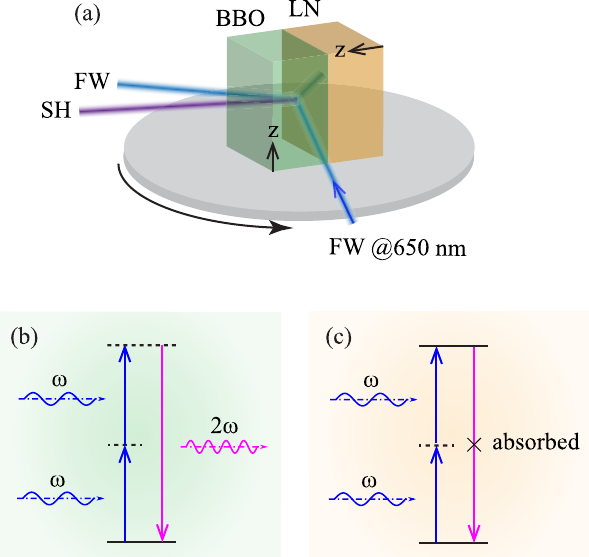
Figure 3. ( a ) Setup of experiment that enhanced UV second-harmonic wave at the interface of BBO and LN. ( b ) and ( c ) are energy-level descriptions of second-order nonlinear process with SH wavelength 325 nm in BBO and LN, respectively.